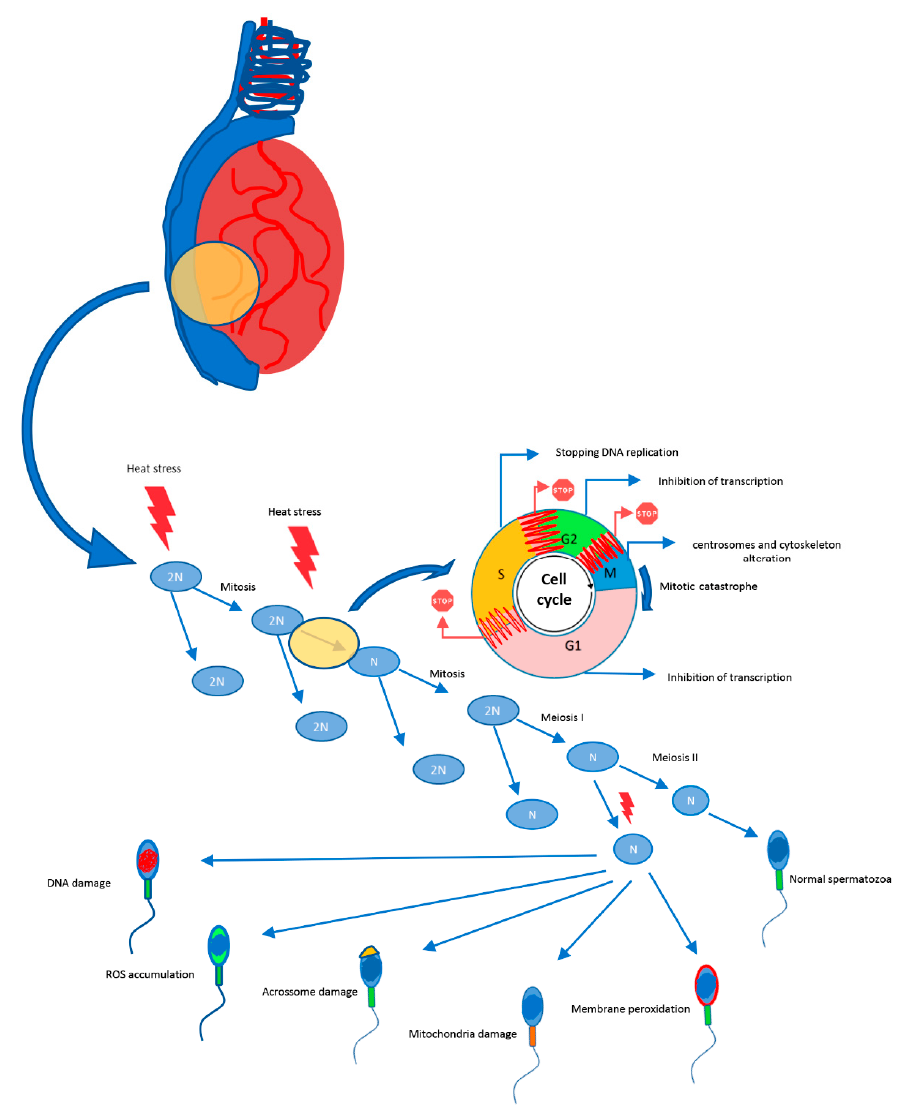
Figure 1. Effect of heat stress on the course of spermatogenesis.